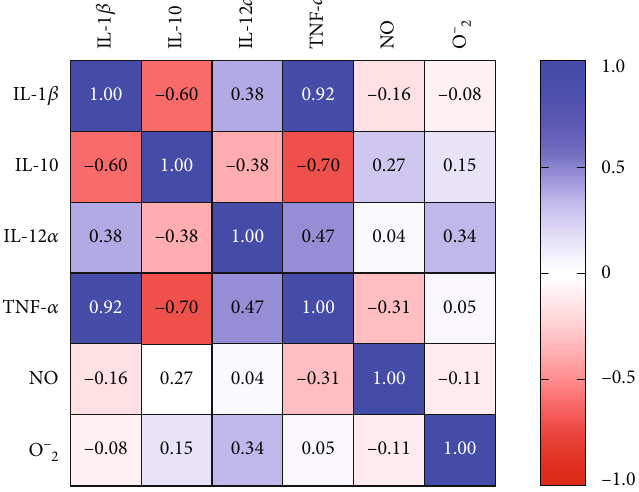
Figure S1: mean (+SD) viability of THP-1-derived macro- phages following exposure to di ff erent concentrations of test drugs. (Supplementary Materials)